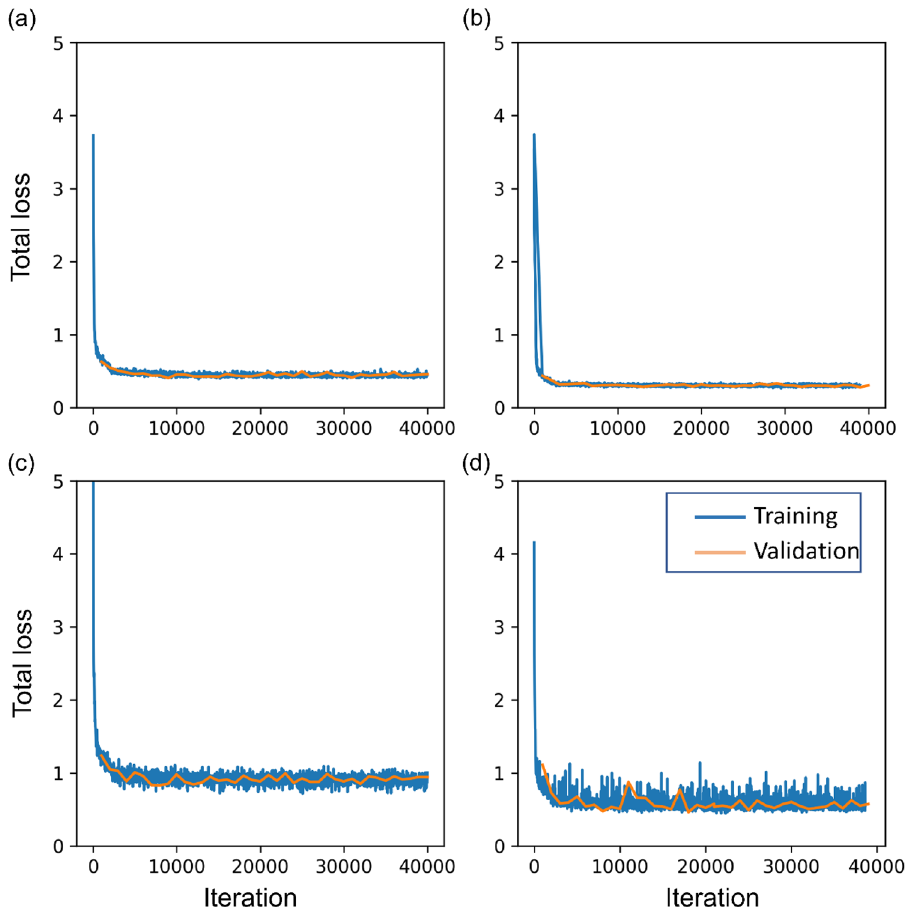
Figure 4. Graph showing a total loss for training and validation across iterations for various models, including the model trained with ( a ) real plant instance-based synthetic images, ( b ) GAN-derived plant instance-based synthetic images, ( c ) real images, and ( d ) a mixed dataset of real and synthetic